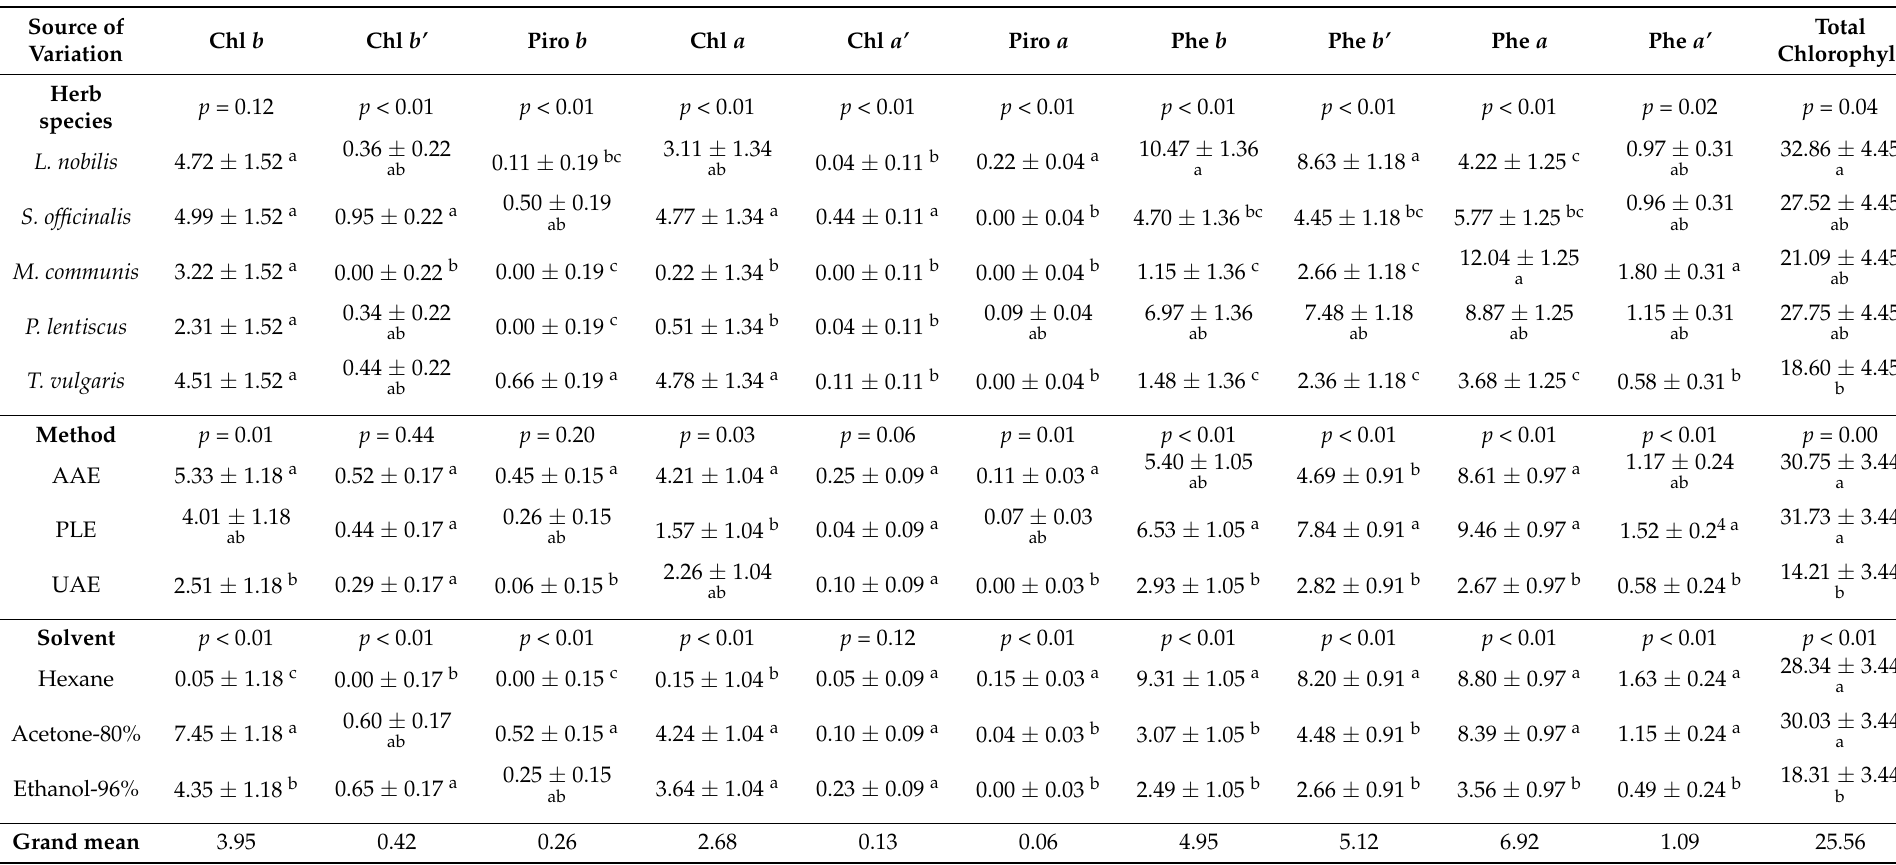
Table 2. Chlorophyll content, as determined by the HPLC-DAD method (mg 100 g − 1 DW), in the extracts of selected Mediterranean herbs obtained through sequential solvent extraction by different extraction